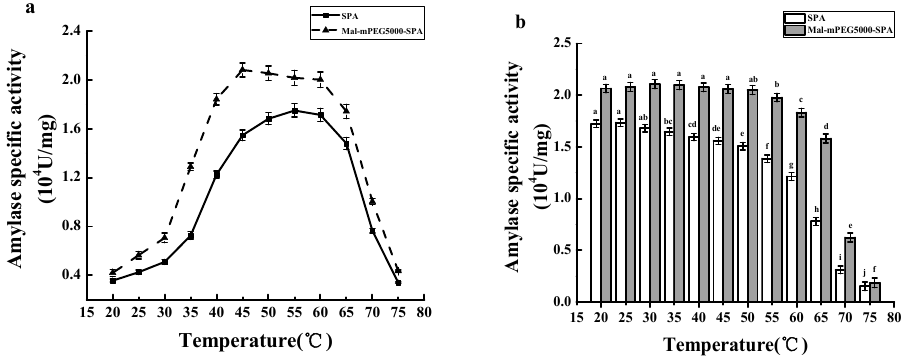
Figure 9. Temperature profiles of Mal-mPEG5000- SPA and SPA. ( a ) Optimum enzymolysis temperature; ( b ) Thermal stability. Significant difference in each column are expressed as different superscript letters ( p < 0.05).